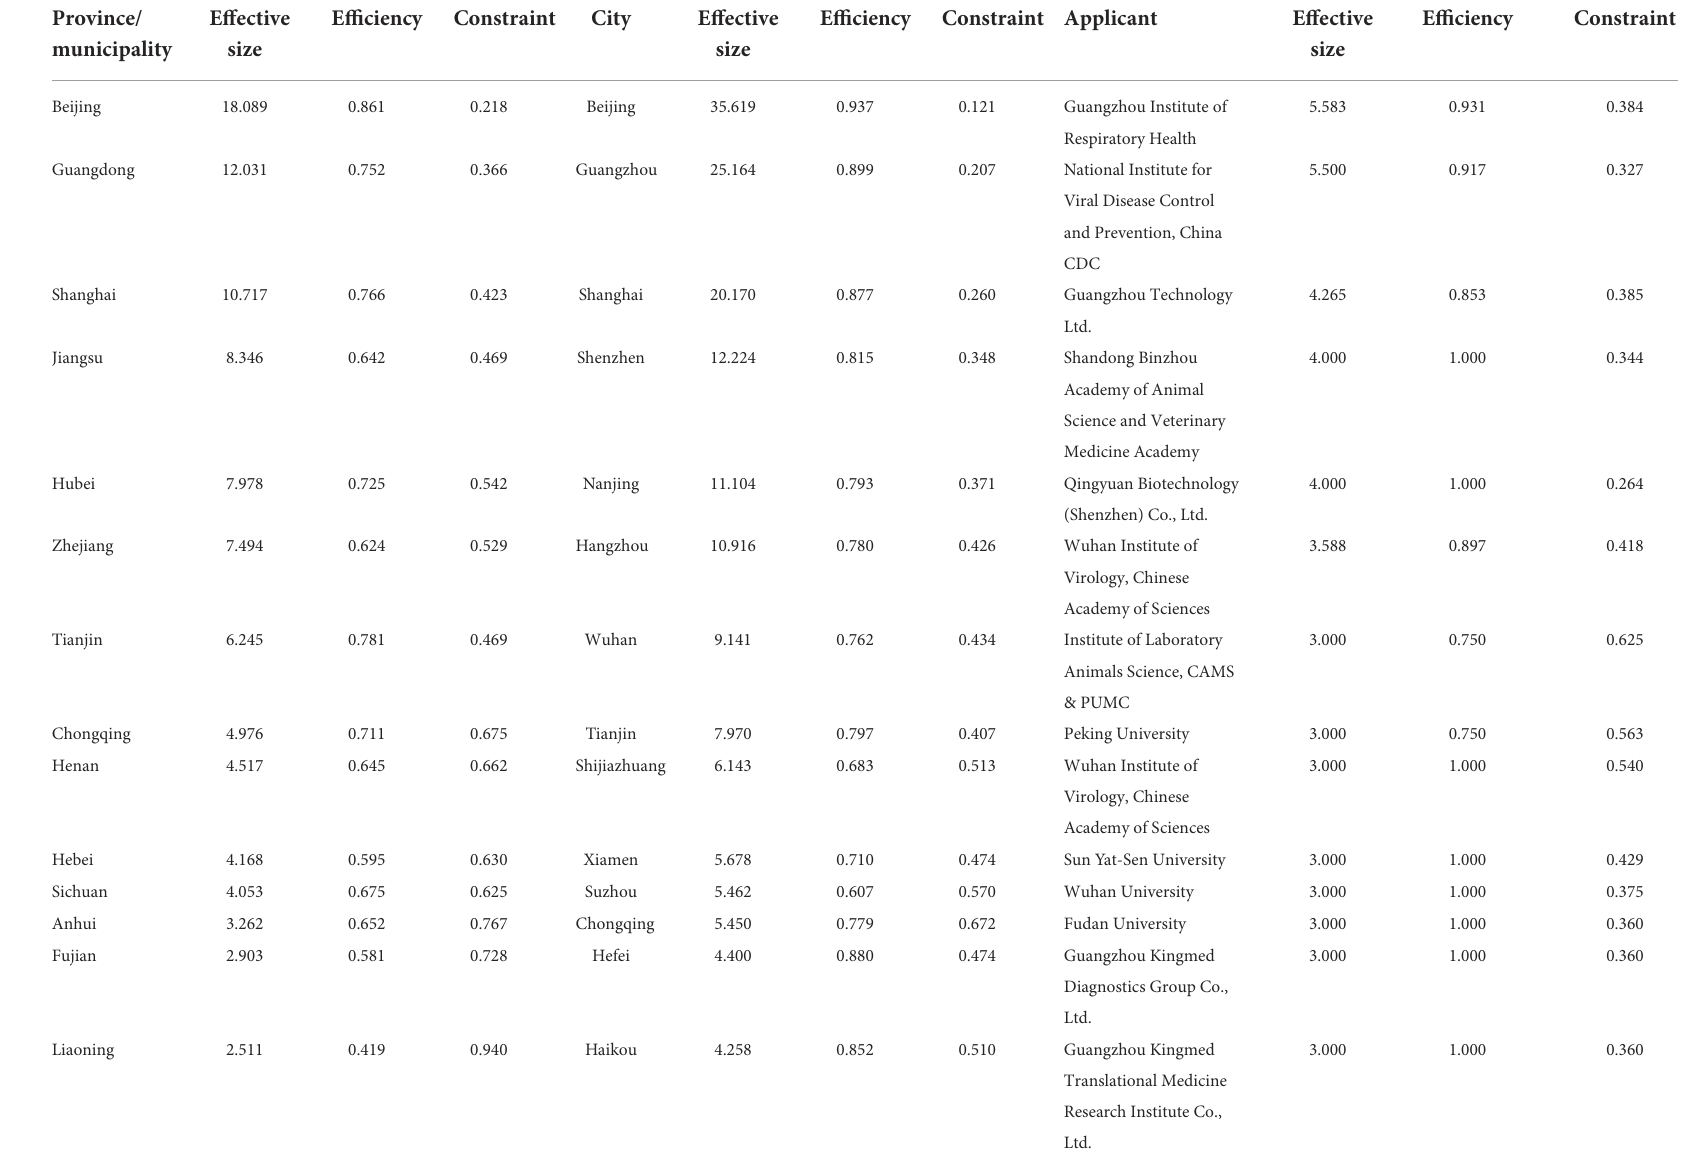
TABLE 5 Structural holes of top 20 nodes in the COVID-19 patent cooperation network. Province/ Effective Efficiency Constraint City Effective municipality size